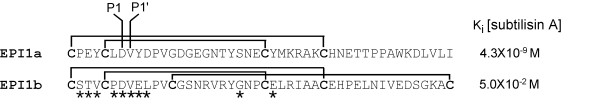
Primary structure alignment of two Kazal domains of EPI1 and the predicted inhibition constants against subtilisin A. The conserved cysteine residues in both domains are shown in bold. The putative P1-P1' sites and the disulfide linkages predicted based on the structure of other Kazal domains are shown. The putative 10 hypervariable contact residues are marked with asterisks. The numbers represent the inhibition constants of two Kazal domains against subtilisin A predicted with the Laskowski algorithm.